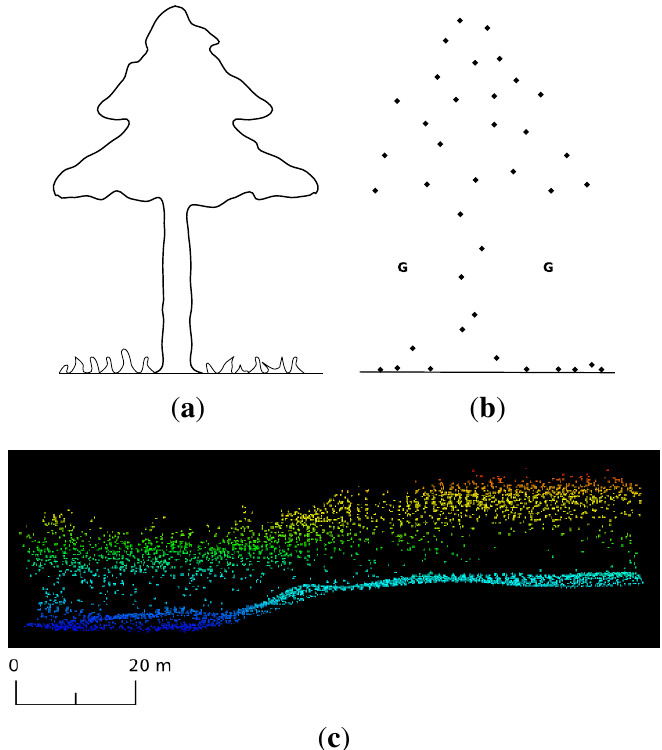
Figure 3. Illustration of how a partial gap is formed (marked with a G) below a tree crown ( a ) in a LiDAR point cloud ( b ) due to most of LiDAR pulses being blocked by the crown and the absence of reflecting objects between the crown and the ground; ( c ) shows a partial gap formed below the canopy in a real LiDAR point